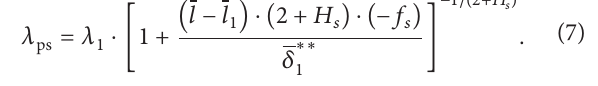
Table 1: Initial data for channel diffuser design.